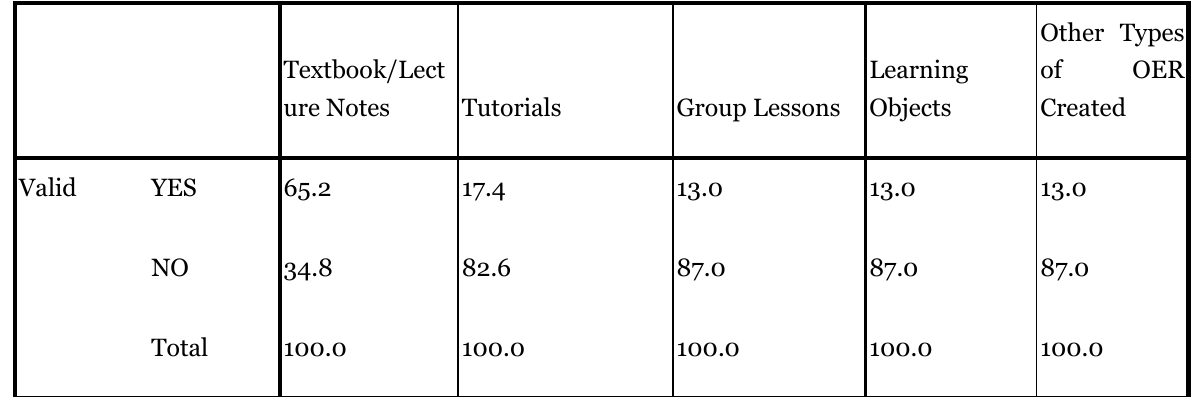
Type of OER Created by